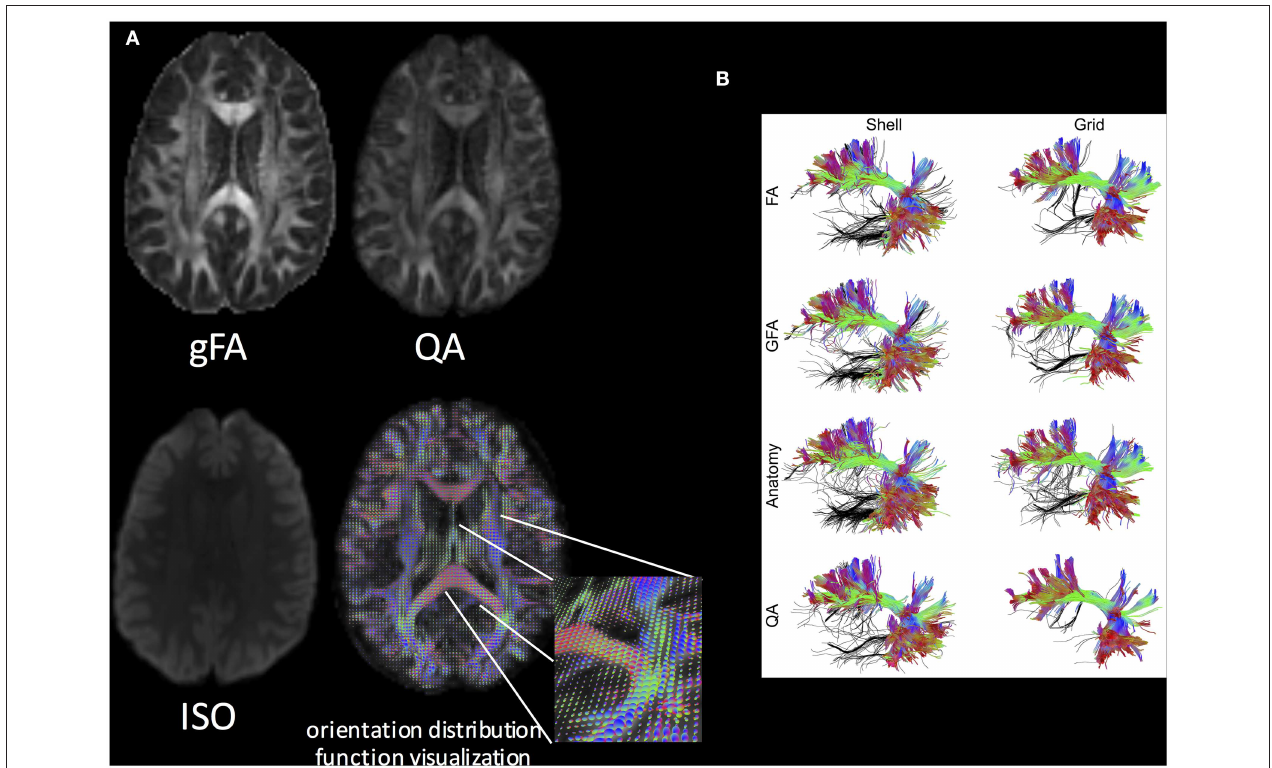
FIGURE 6 | (A) Q-space diffeomorphic reconstruction using DSI Studio. gFA, QA, ISO (represents background isotropic diffusion contributed from CSF), and the ODF visualization are shown. (B) The performance of the FA-aided, GFA-aided, anatomy-aided, and QA-aided tractographies showing arcuate fasciculus using shell and grid sampling data. The false tracks are colored in black, whereas accurate trajectories are coded by directional color. The tractographies using FA, GFA, and anatomical information show substantially more false tracks than do those using QA. The best performance can be observed in the tractography using QA and the grid dataset. Reproduced with permission from Yeh et al.